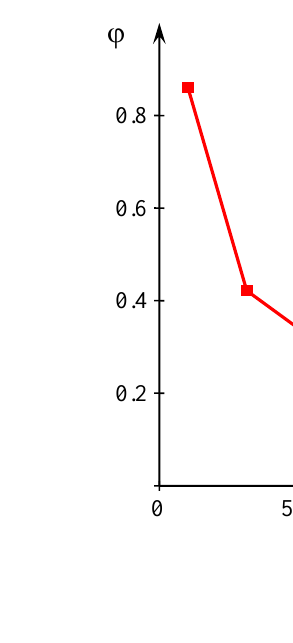
Figure 6. Dependence of the triiodide concentration [I 3 − ] (mmol / l) in samples taken in the center and at the periphery of the MRFIJ on the time since the preparation of the initial solutions (Ic is the concentration in the center and Ip is the concentration at the periphery; the numbers (100–2000) correspond to the jets flow rate Q j , mL / min). 2 θ = 97.5 ◦